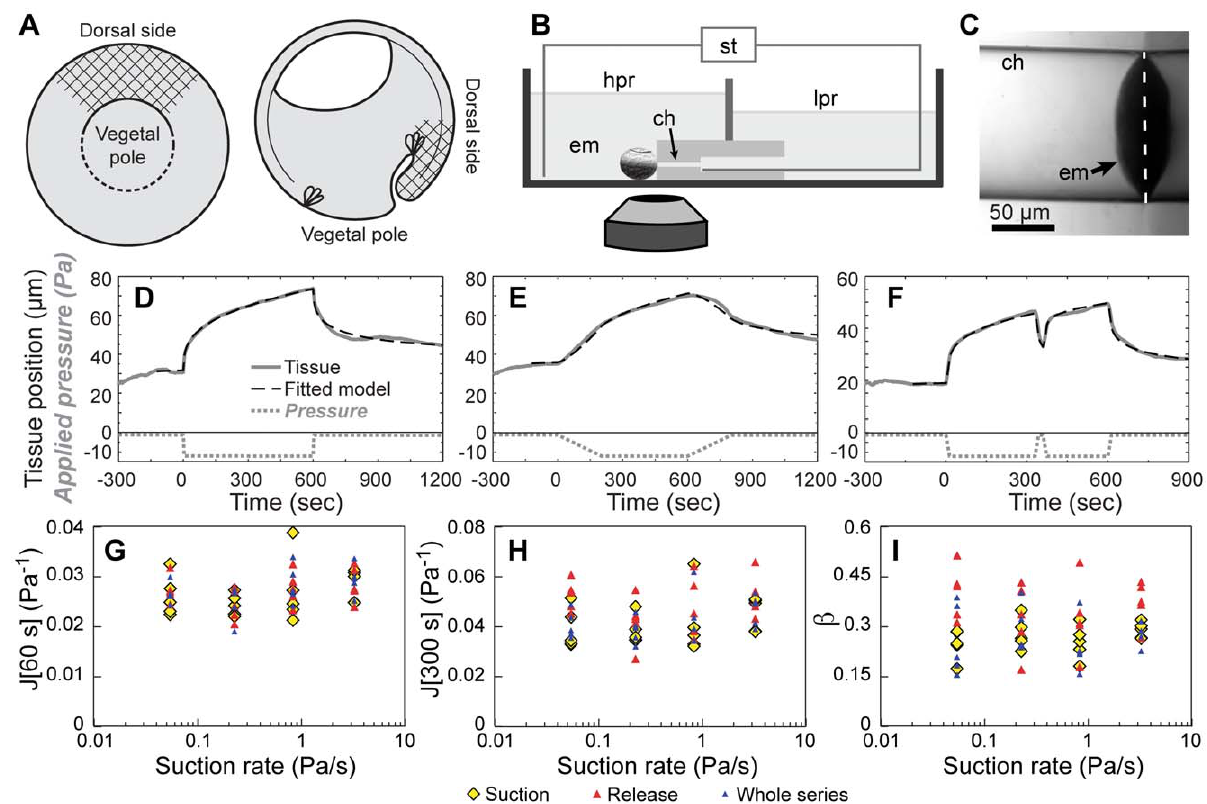
Figure 1. Mechanical response to micro-aspiration was independent of loading rate. A) Diagram of X. laevis gastrula (stage 11): vegetal view (left); cross section (right). Hatched areas indicate where measurements were made. B) Diagram of the micro-aspirator (not to scale) on the stage of an inverted microscope. An embryo (em) is pressed to the channel (ch) using a polished glass rod (not shown). The pressures in the high- and low- pressure reservoirs (hpr and lpr) are adjusted hydrostatically. The aspirated tissue is imaged from below. C) Aspirated tissue (arrow) is visible in the channel. The bulk of the embryo is on the right of the channel opening (dashed line) but is hidden by reflections off the channel block surface. D–F) Tissue positions and curve fits using the power-law model for three different pressure histories. G-I) Viscoelastic parameters at different suction rates: compliance at 60 s (G), compliance at 300 s (H) and power-law exponent (I). Different symbols indicate which part of the data were fitted: "suction": 2 120 to + 600 s; "release": + 540 to + 1200 s; "whole series": 2 120 to + 1200 s.